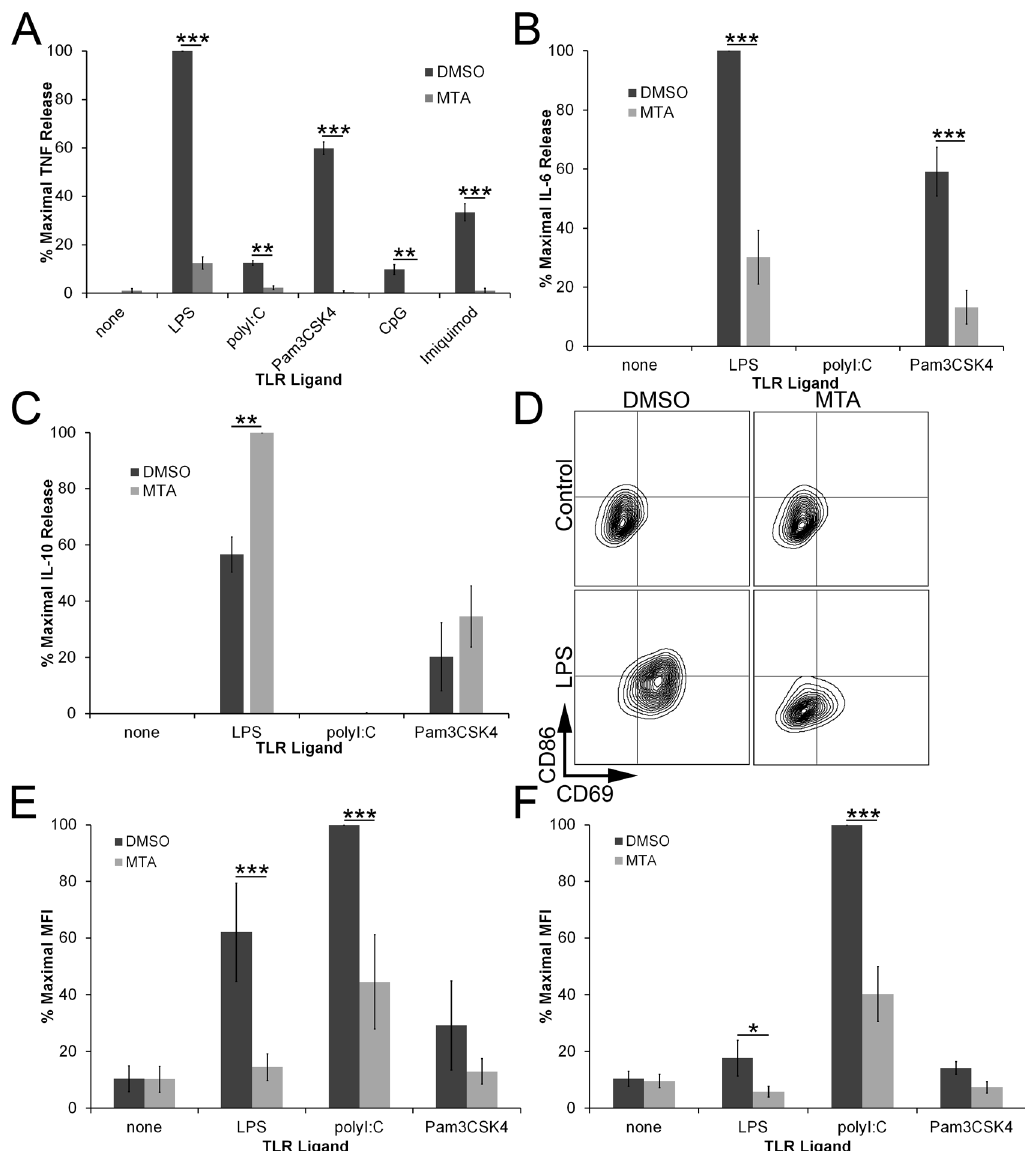
Figure 1. MTA inhibits TLR responses. BMDM were incubated overnight with DMSO or 200 m M MTA in the absence or presence of the following TLR ligands: 10 ng/mL LPS, 10 m g/mL polyI:C, 1 m g/mL Pam3CSK4, 6.67 m M CpG or 2 m g/mL Imiquimod. Supernatants were assayed for TNF a (A), IL-6 (B) or IL-10 (C) production by ELISA while cells were harvested, stained and analyzed for surface CD69 (D,E) or CD86 (D, F) expression by FACS. Graphs represent mean 6 sem of 3 (A, E, F), 4 (C) or 5 (B) experiments. * p , 0.05, ** p , 0.01, *** p , 0.001.